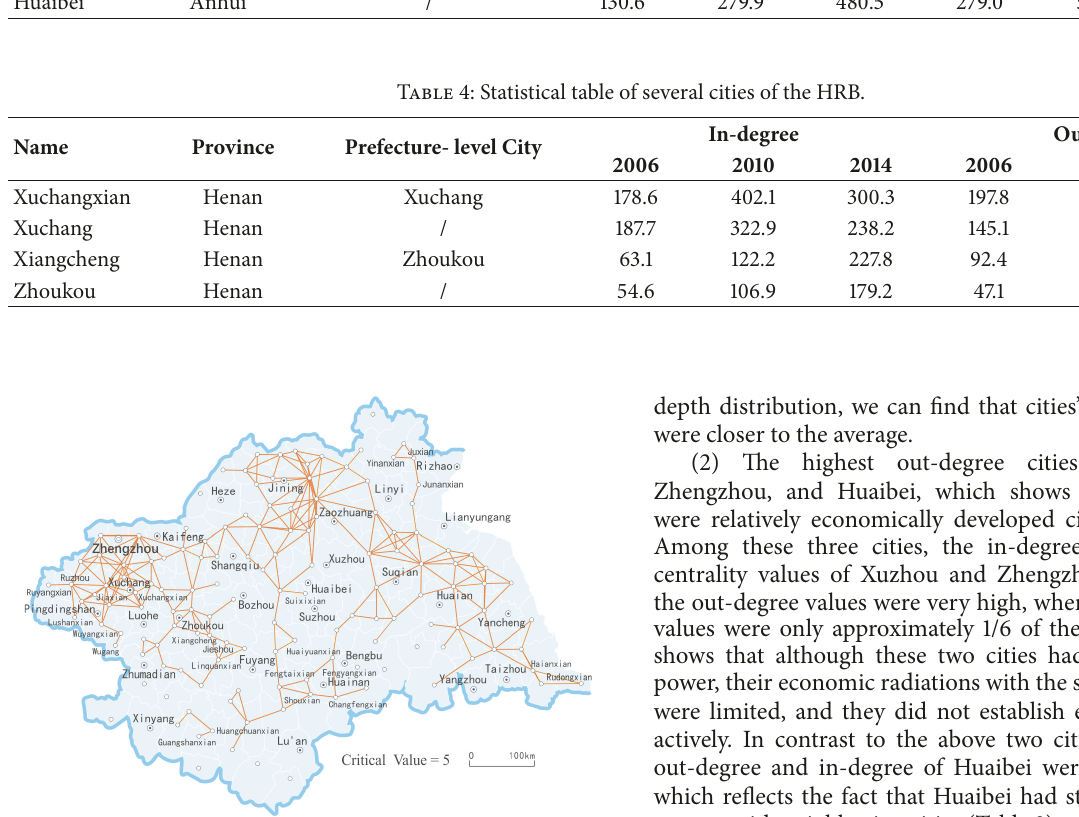
Figure 4: Urban network structure in 2014 (at the county